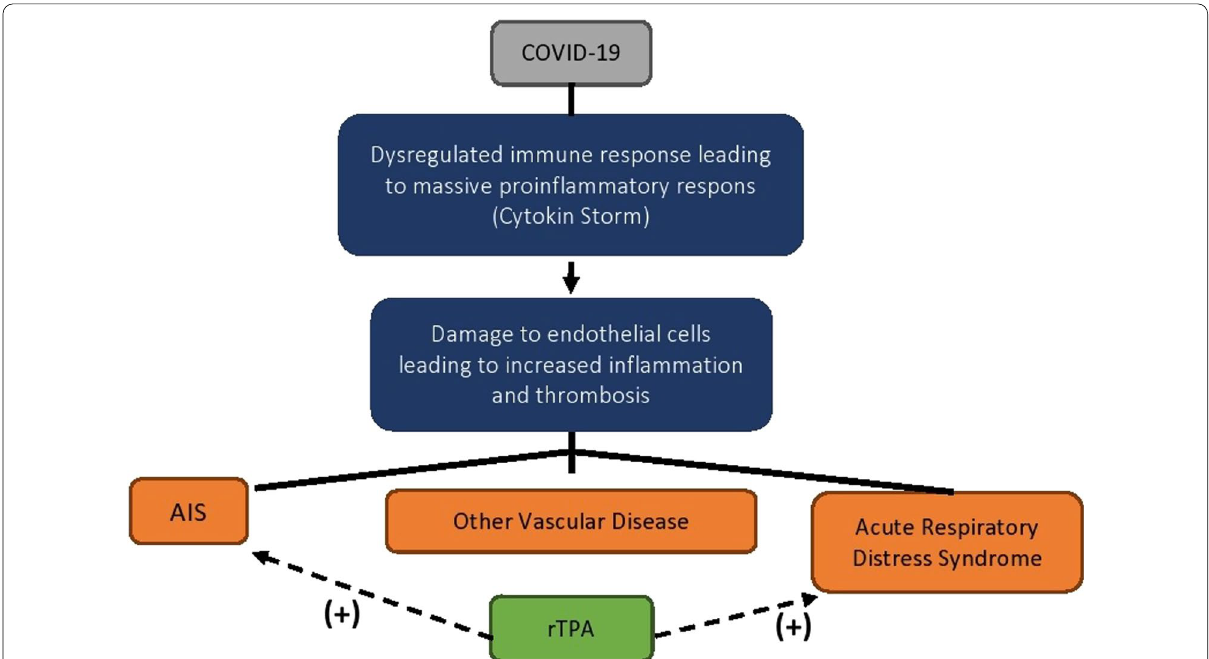
Fig. 3 Possible mechanism of thrombosis and effect of trombolysis drugs in